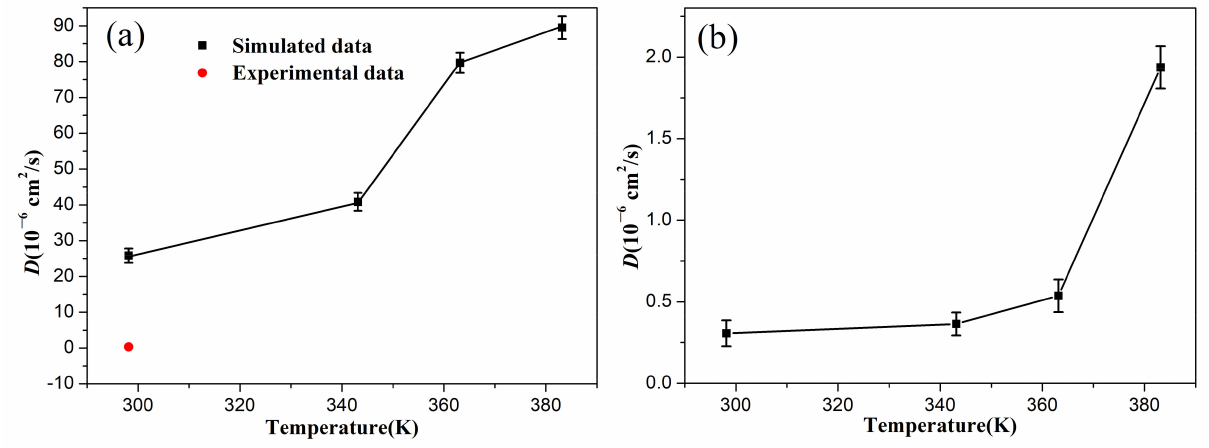
Figure 5. The diffusion coefficients of the oxygen in the uncompressed ( a ) and compressed ( b ) rubber as a function of